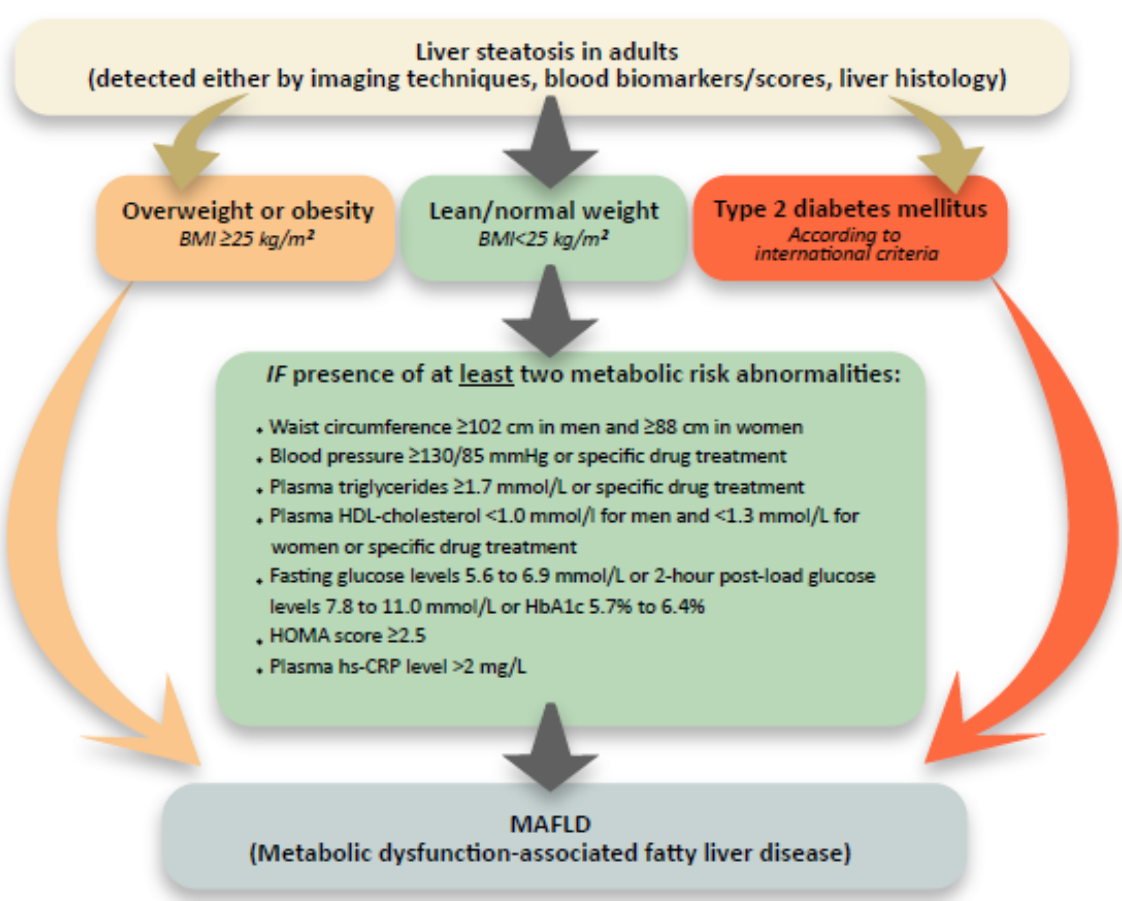
Figure 1. MAFLD criteria. Addapted from Eslam, M., et al. A new definition for metabolic dysfunction-associated fatty liver disease: An international expert consensus statement [1]. BMI — body mass index. HOMA score — Homeostatic Model Assessment for Insulin Resistance score. hsCRP — high-sensitivity C-reactive protein.